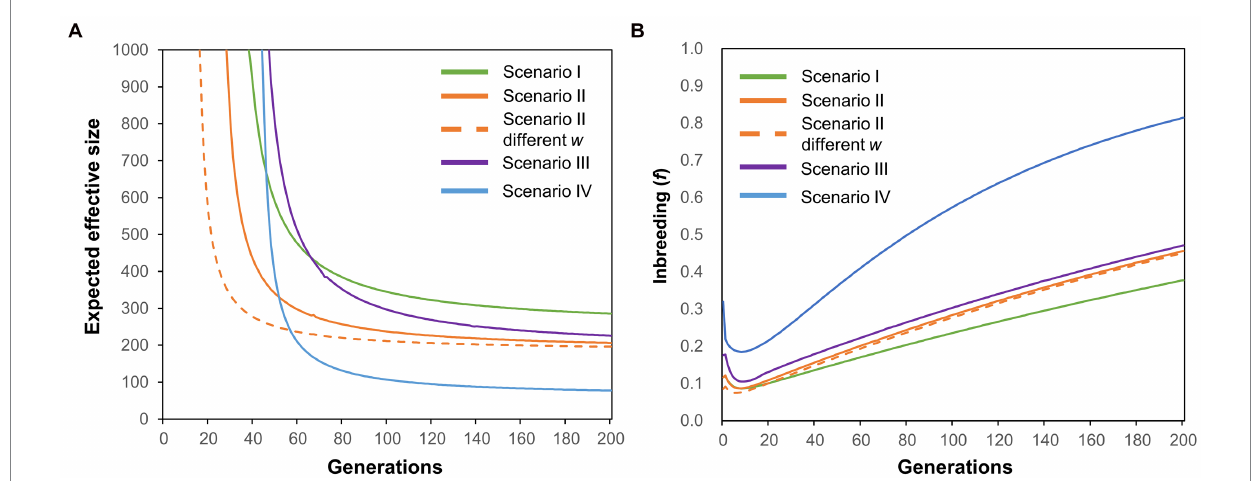
FIGURE 4 Expected effective size (A) and inbreeding levels (B) over 200 generations in a metapopulation under four scenarios. See Figure 2 and relevant descriptions in the main text for details regarding the four